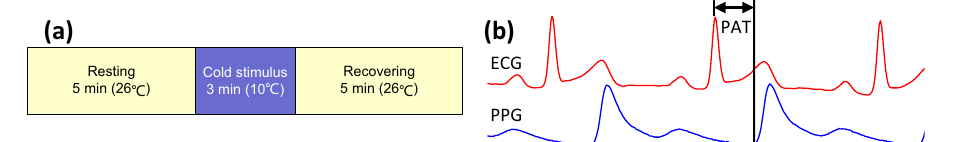
Figure 1. Illustration of the methods. ( a ) The procedures of the cold stimulation experiment. ( b ) Illustration of the pulse arrival time